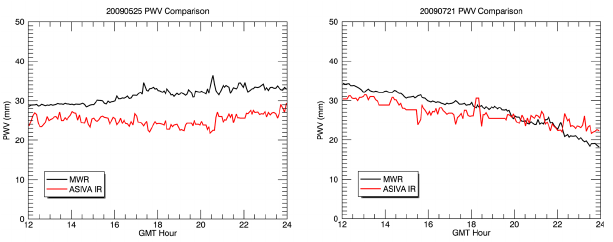
Figure 11. Comparison of MWR with ASIVA PWV data for a) May 25, 2009 and b) July 21, 2 Fig. 11. Comparison of MWR with ASIVA PWV data for (a) 2009. 3 25 May 2009 and (b) 21 July